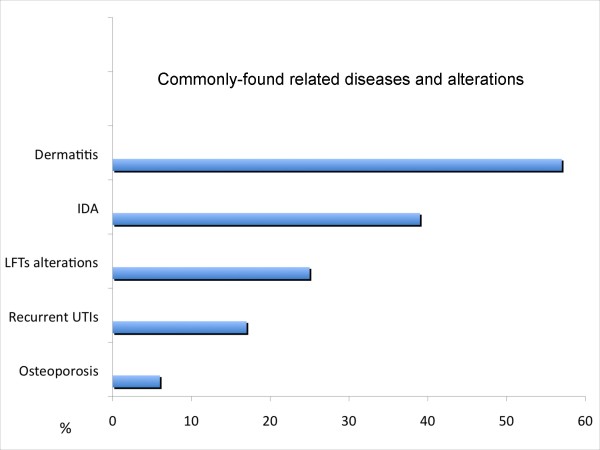
Percentages of individuals who scored positive for several associated conditions are shown. IDA = Iron Deficiency Anemia; LFTs = Liver Function Tests; UTIs = Urinary Tract Infections